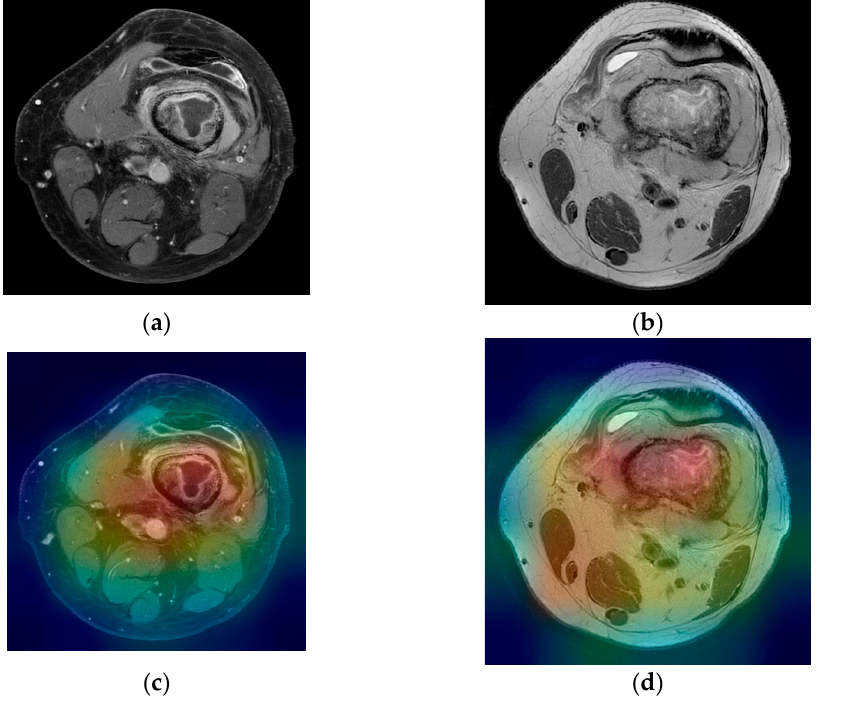
Figure 8. ( a ) Femur malignant tumor—T1 FS with contrast weighted image; ( b ) femur malignant tumor—T2 weighted image; ( c , d ) corresponding class activation maps.